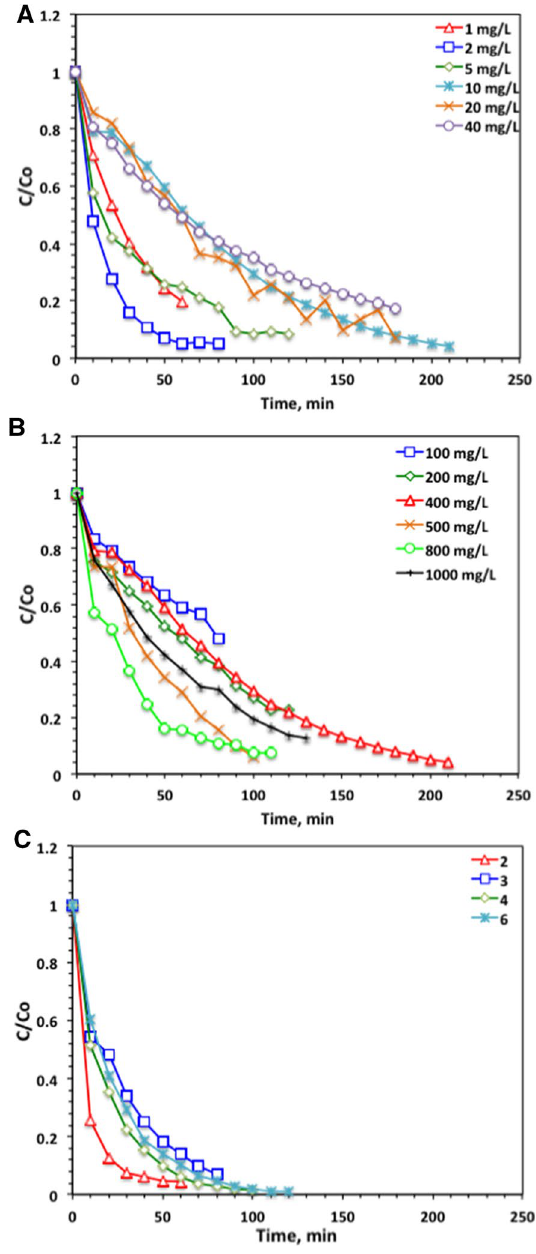
Fig. 6 Effect of CS-M-based Fenton system parameters on BB9 oxi- dation, A H 2 O 2 concentration effect; B catalyst dosing effect and C pH